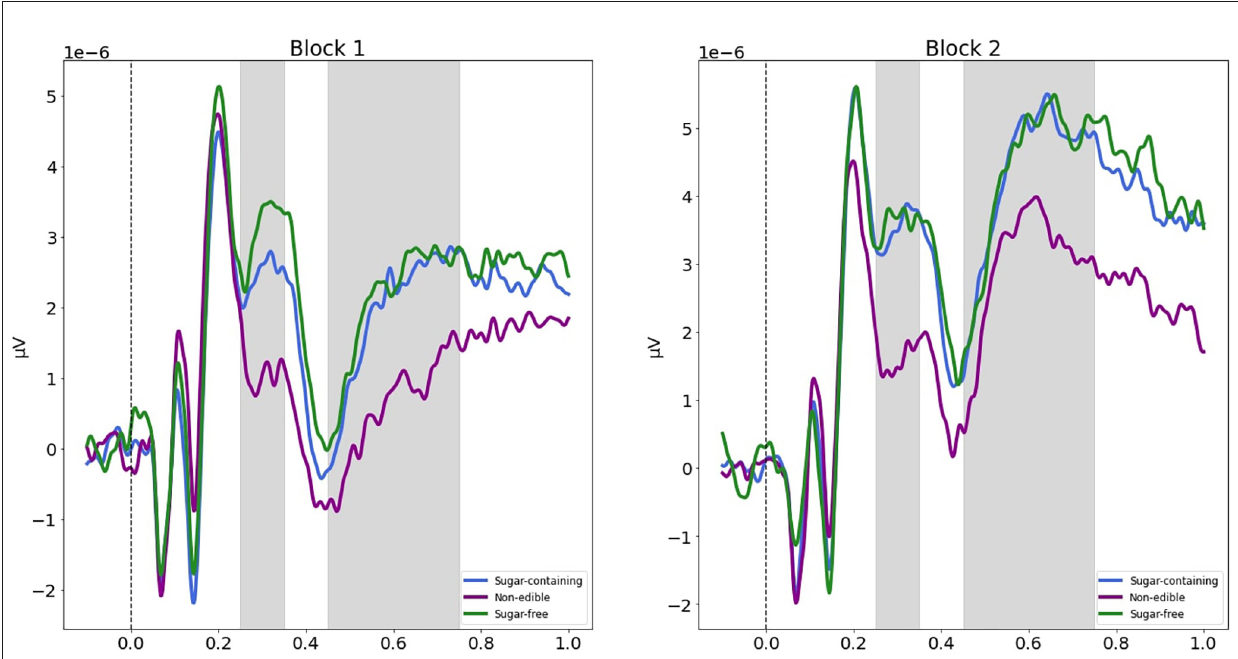
FIGURE5 P300 and LPP components shaded in gray in two consecutive time windows (earlier and later, correspondingly) in response to each product category, in the first (left) and the second (right) block of the bidding task. In both blocks, the mean P300 amplitude and the mean Late Positive Potential (LPP) amplitude were found to be significantly lower for non-edible products compared to sugar-containing and sugar-free products. The gray areas indicate the time window in which the P300 and the LPP were measured, based on previous